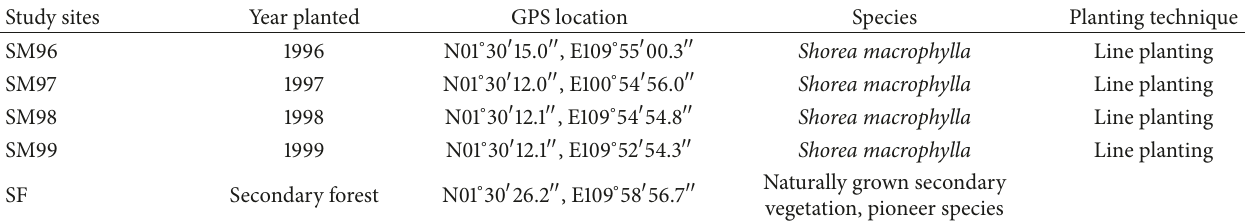
Table 1: General information of the study sites; SM96, SM97, SM98, SM99 (rehabilitation sites), and secondary forest (SF). Study